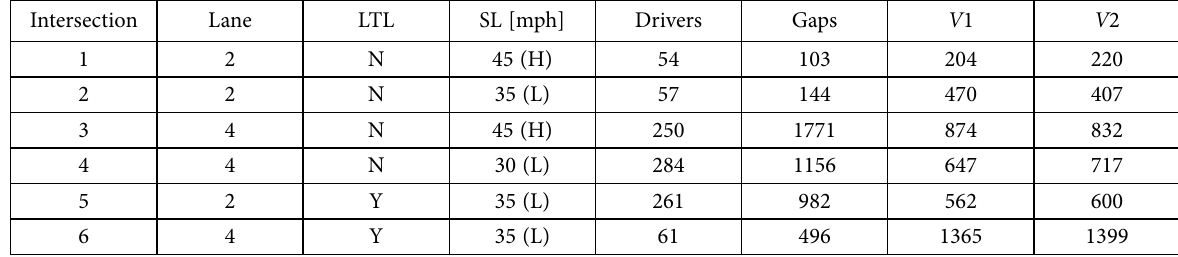
Table 1. Number of drivers and gaps observed by intersection Intersection